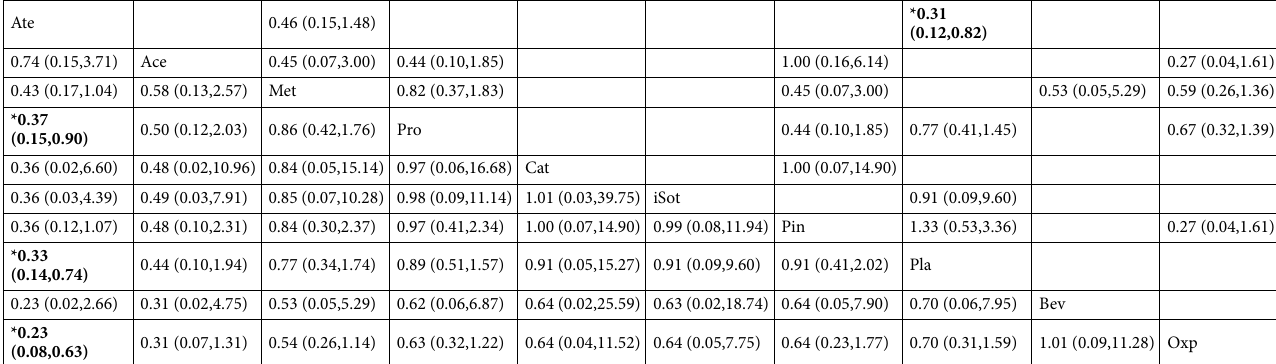
Table 2. League table of association between asthma exacerbation and beta-blocking agent prescription: sensitivity test of removal of zero event. Pairwise (upper-right portion) and network (lower-left portion) meta-analysis results are presented as estimate effect sizes for the outcome of asthma exacerbation incidence rate. Interventions are reported in order of mean ranking of incidence of asthma exacerbation, and outcomes are expressed as odds ratio (OR) (95% confidence intervals). For the pairwise meta-analyses, OR of less than 1 indicate that the treatment specified in the row got less incidence of asthma exacerbation than that specified in the column. For the network meta-analysis (NMA), OR of less than 1 indicate that the treatment specified in the column got less incidence of asthma exacerbation than that specified in the row. Bold results marked with * indicate statistical significance. Ace oral acebutolol, Ate oral atenolol, Bev oral bevantolol, Bis oral bisoprolol, Car oral carvedilol, Cat oral carteolol, Cel oral celiprolol, CI confidence interval, CPro oral celiprolol and propranolol, ES effect size, iEsm infusion of esmolol, iPac infusion of practolol, iPLab infusion of propranolol and labetalol, iPro infusion of propranolol, iSot infusion of sotalol, iTol infusion of tolamolol, Lab oral dilevalol or oral labetalol, Met oral metoprolol, Nad oral nadolol, NMA network meta-analysis, OR odds ratio, Oxp oral oxprenolol, Pin oral pindolol, Pla Placebo/control, Pra oral practolol, Pro oral propranolol, Sot oral sotalol, SUCRA surface under the cumulative ranking curve, Tim oral